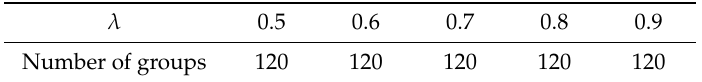
Table 2. The relationship between λ and the number of groups (diesel